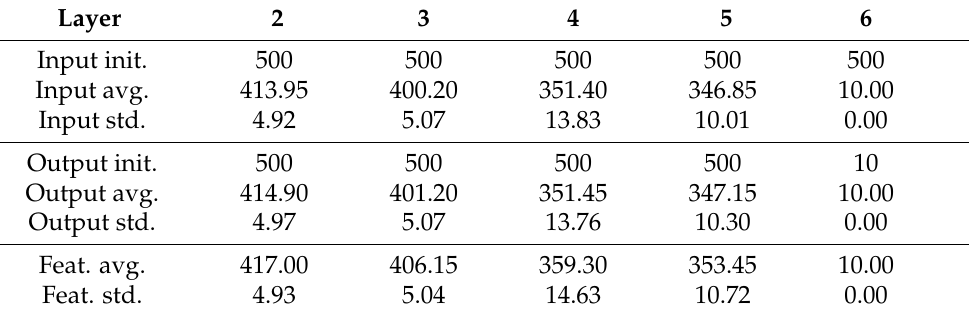
Table 2. Learned model architecture with λ 1 = 20.0. Init = initial